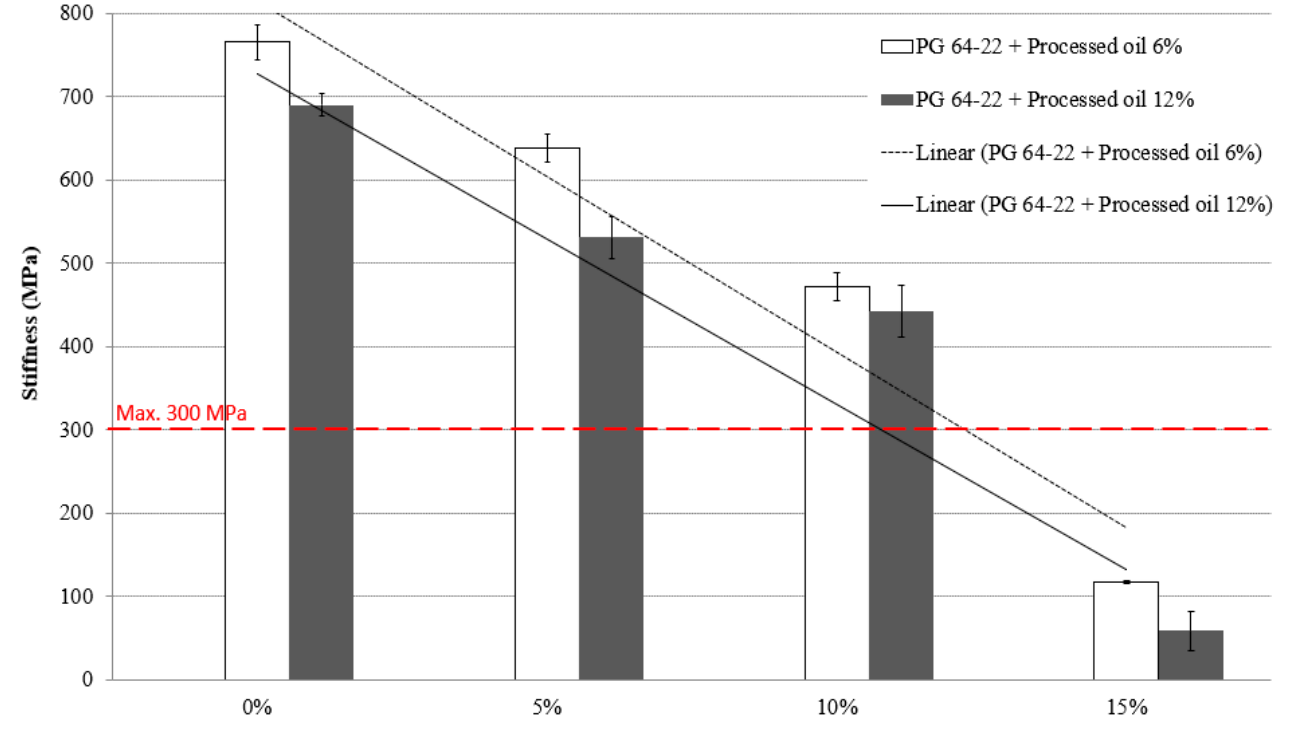
Figure 8. Stiffness of RTFO + PAV aged PG 64-22 binder with processed oil as a function of SBS content at − 24 °C. Table 11. Statistical analysis results of stiffness for RTFO + PAV aged PG 64-22 with processed oil as a function of SBS content at − 12 ◦ C ( α = 0.05).